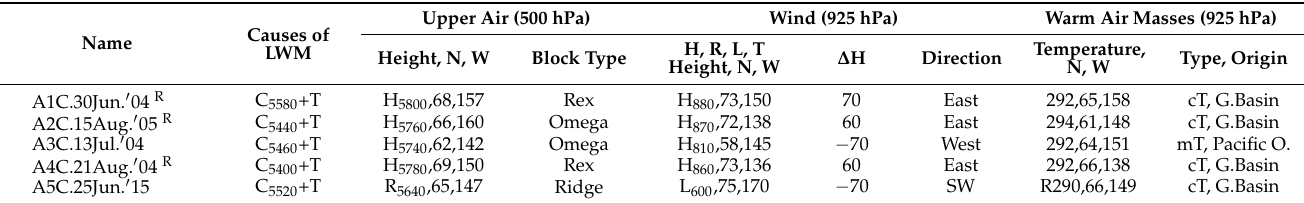
Table 4. Fire weather conditions of top five active fire periods in Alaska.